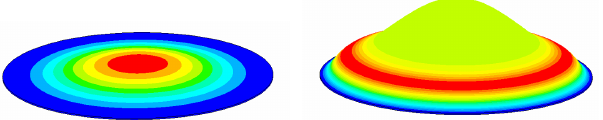
Figure 12. The mode shapes of the circular plate and the bionic structure. ( a ) The circular plate. ( b ) The bionic structure.